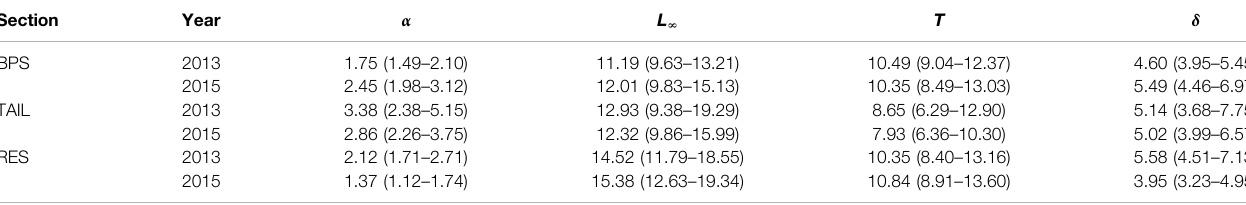
(cid:12)(cid:12)(cid:12)(cid:12) 1 / τ k